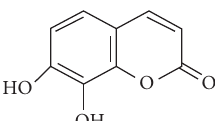
Figure 1: Structure of